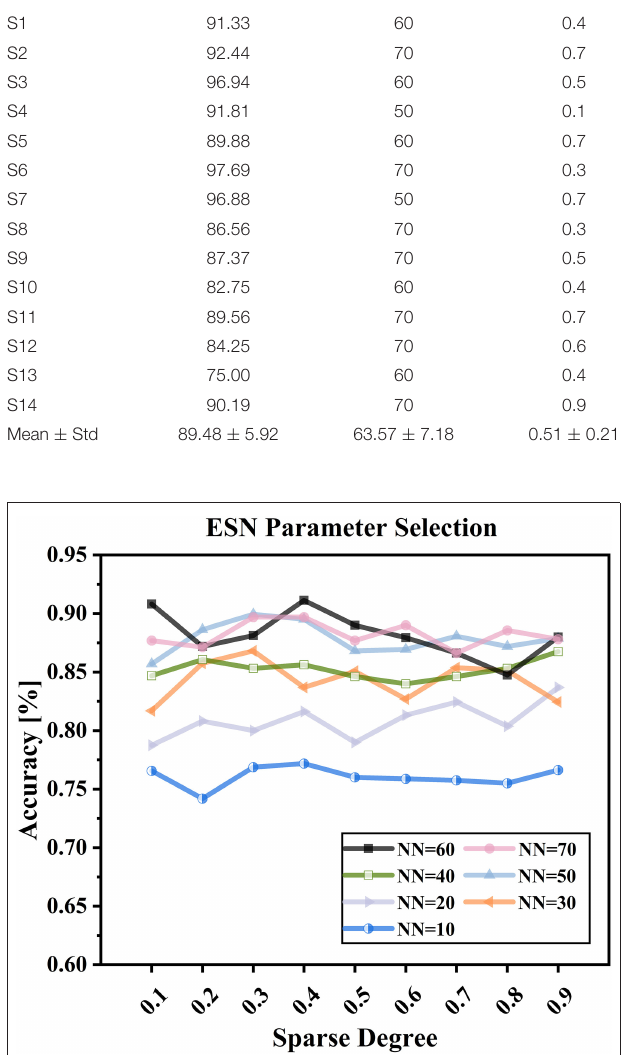
FIGURE 7 | ESN parameter selection with different reservoir sparse degree c and reservoir size NN .